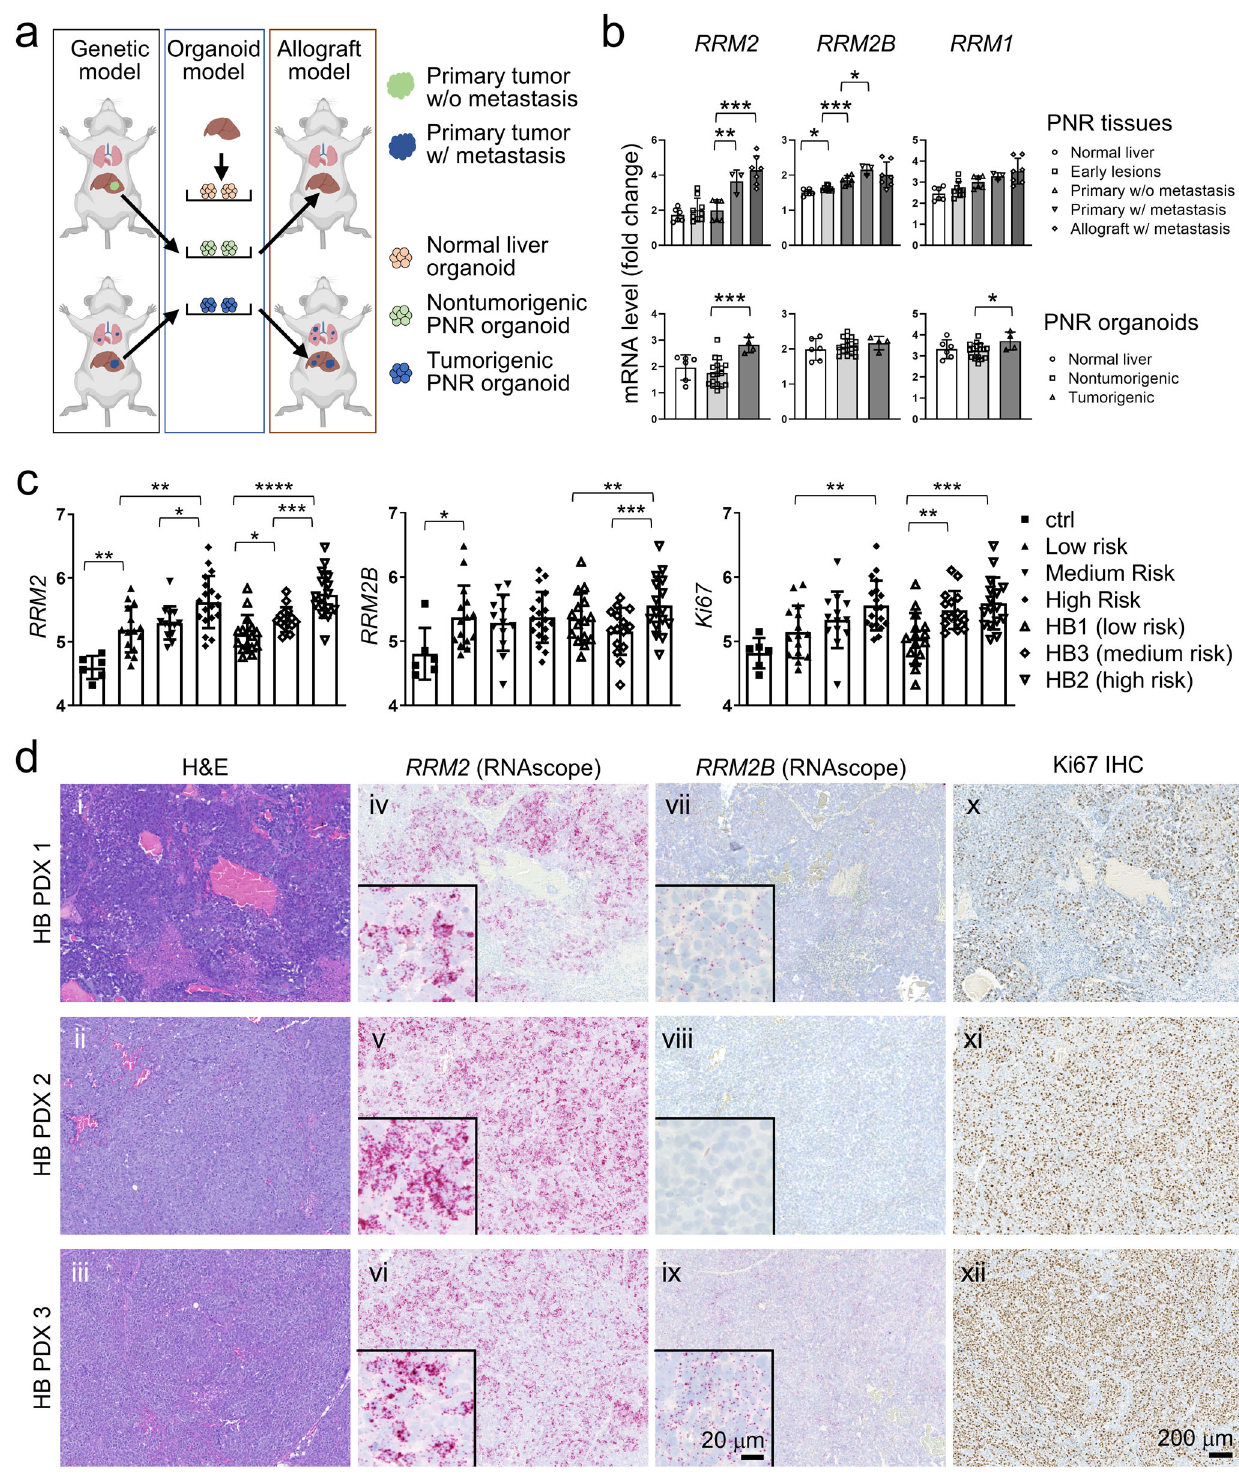
Fig. 1 RRM2, not RRM2B, is associated with HB progression in mice and patients. a Schematic illustration (created with BioRender.com) showing the establishment of PNR genetic mouse model, organoid model, and orthotopic allograft models. b Quantitative comparison of the gene expression of the three RNR subunits in PNR tumor tissues ( n = 6, 9, 6, 3, and 7 for the fi ve indicated groups, respectively) and organoids ( n = 6, 17, and 4 for the three indicated groups, respectively). c Expression of the three RNR subunits in the control liver ( n = 6) and pathologically-de fi ned HB patient risk groups (low, medium, and high; n = 15, 13, and 19, respectively) and molecularly-de fi ned risk groups (HB1, HB3, and HB2 from low- to high-risk; n = 15, 15, and 16, respectively) from a publicly available HB transcriptomics database 24 . d H&E staining (i – iii), RNAscope staining for RRM2 (iv – vi) and RRM2B (vii – ix), and Ki67 IHC staining (x – xii) on the serial sections of three HB PDX tumors. All images share the same 200 μ m scale bar in (xii). Insets in (iv – ix): higher magni fi cation images of the corresponding RNAscope staining and share the 20 μ m scale bar in the inset in (ix). Student t test: P values: * <0.05; ** <0.01; *** <0.001; **** <0.0001. COMMUNICATIONS BIOLOGY| (2023) 6:249 |https://doi.org/10.1038/s42003-023-04630-7|www.nature.com/commsbio